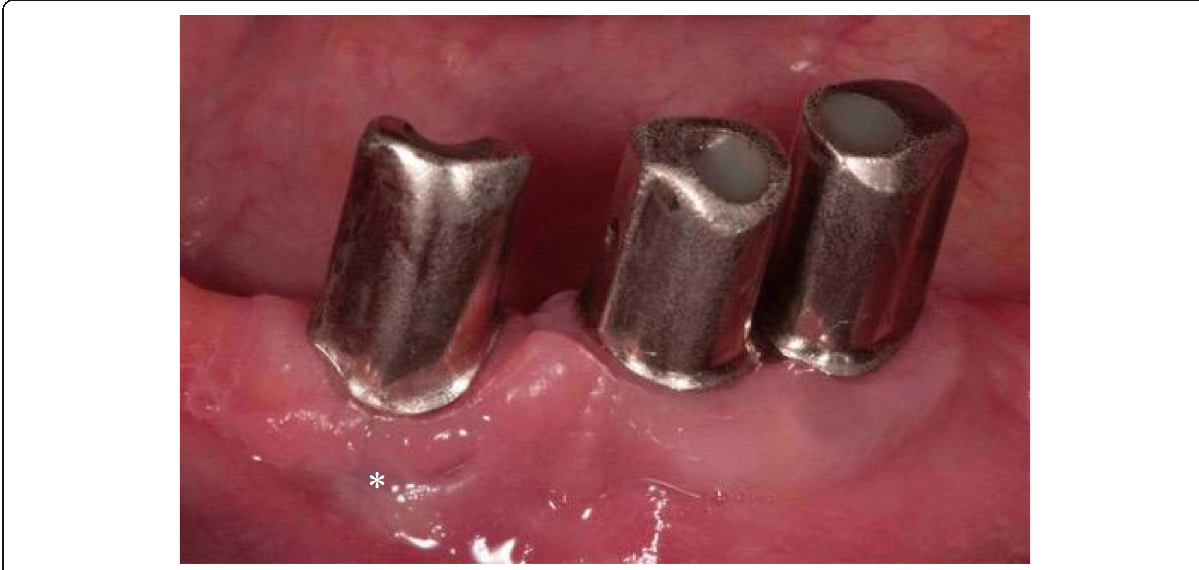
Fig. 3 The clinical findings 7 years after insertion of the superstructure showed at the implants with primary crowns no soft tissue recessions and the keratinized mucosa was > 1 mm. The implant in region 33 showed a blue-livid discoloration buccally (marked by an